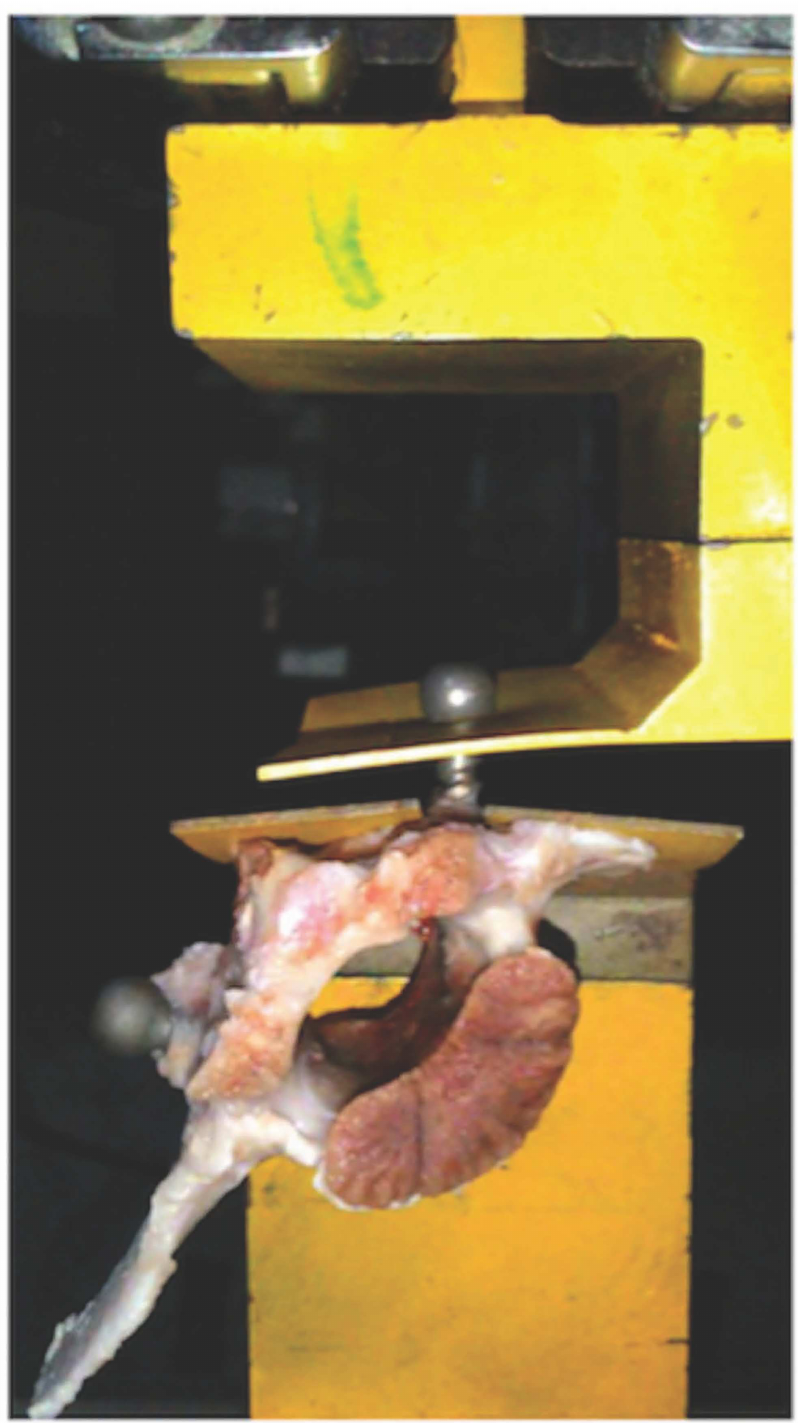
Fig 2. Setup of material testing systemfor pull-out test of pedicle screws.